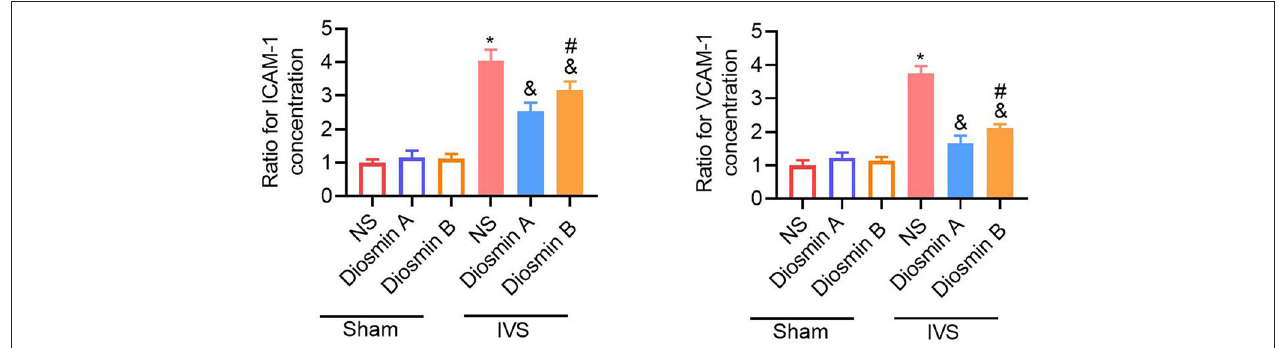
FIGURE 3 | Diosmin alleviates inflammation response. The relative expression of ICAM-1 and VCAM-1 in serum was presented and normalized to the average of the sham/NS group. Sham/NS ( n = 3), sham/diosmin A ( n = 3), sham/diosmin B ( n = 3), IVS/NS ( n = 6), IVS/diosmin A ( n = 7), and IVS/diosmin B ( n = 7). * p < 0.05 vs. sham/NS; & p < 0.05 vs. IVS/NS; # p < 0.05 vs. IVS/diosmin A (ordinary one-way ANOVA’s multiple-comparisons test). IVS, iliac vein compression; ICAM-1, intracellular adhesion molecule-1; VCAM, vascular cell adhesion molecule-1.